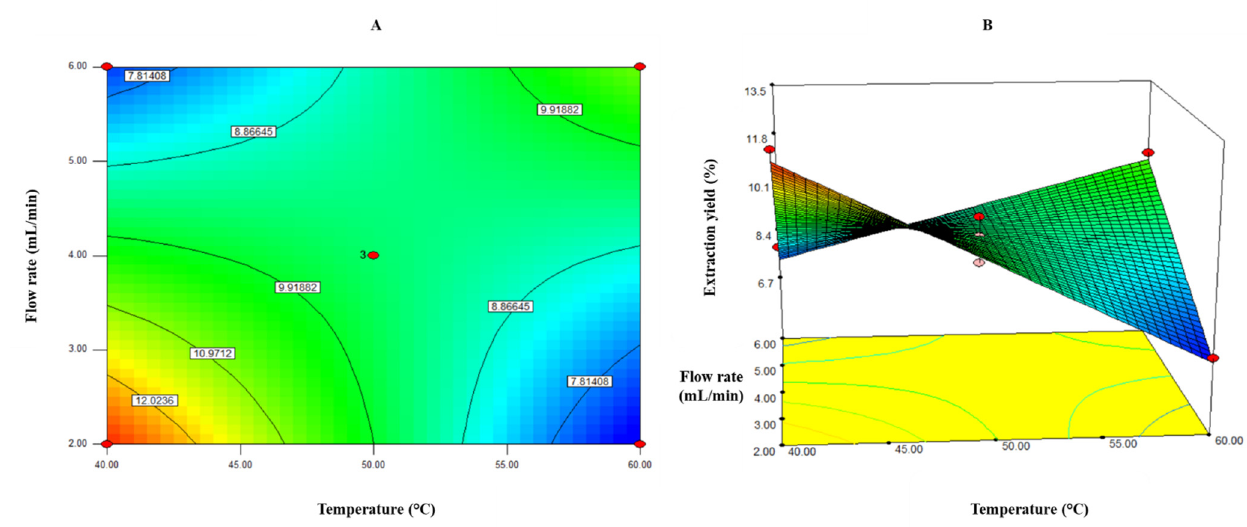
Figure 1. Contour plots ( A ) and response surface ( B ) for the effect of temperature (°C) and flow rate (mL/min) on the extraction yield of supercritical CO 2 extraction of lyophilized liquor. Table 2. Confirmation report of CO 2 supercritical extraction of lyophilized liquor.